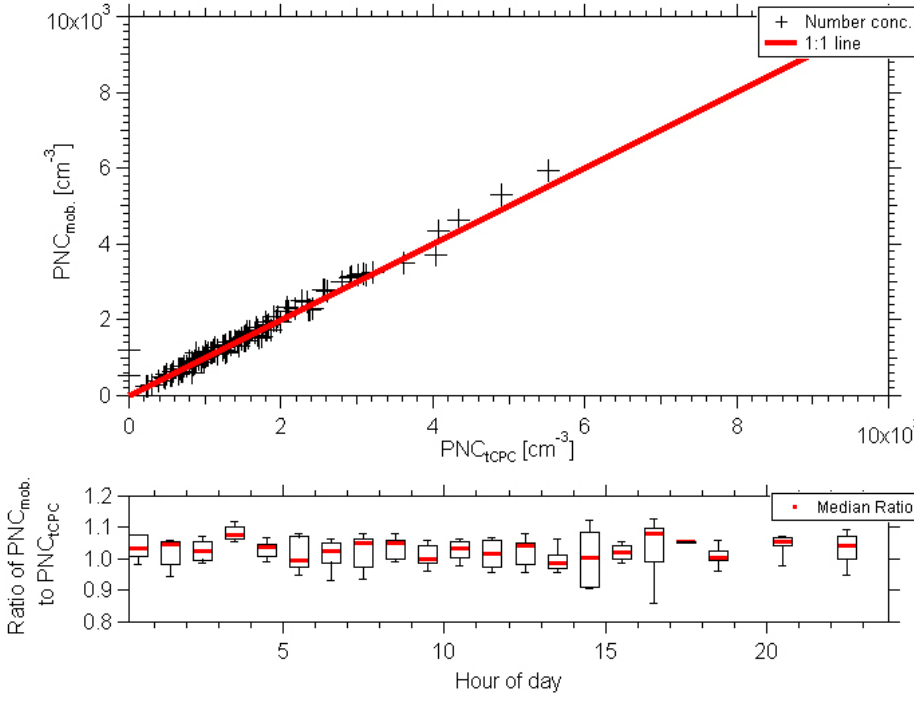
Fig. 6. Same as Fig. 3 but with diffusion